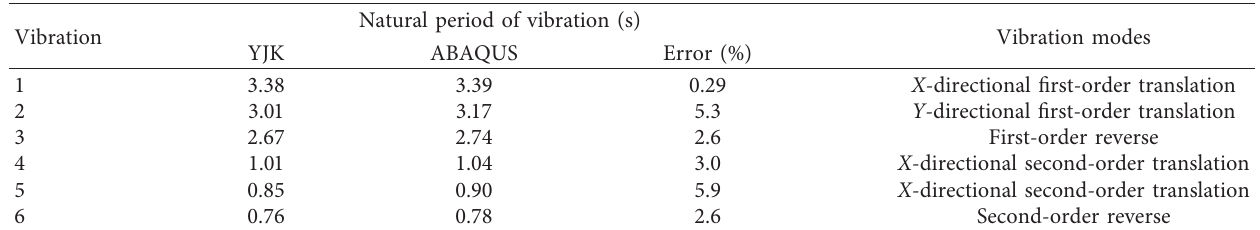
Table 3: Natural period of vibration calculated by ABAQUS and